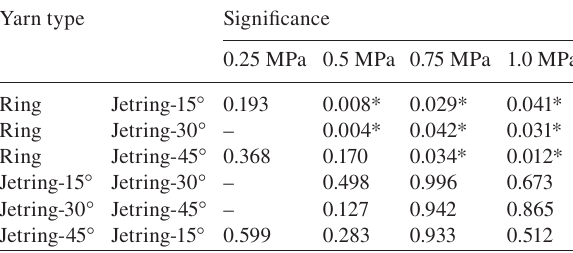
Table 8 ANOVA test results of yarn